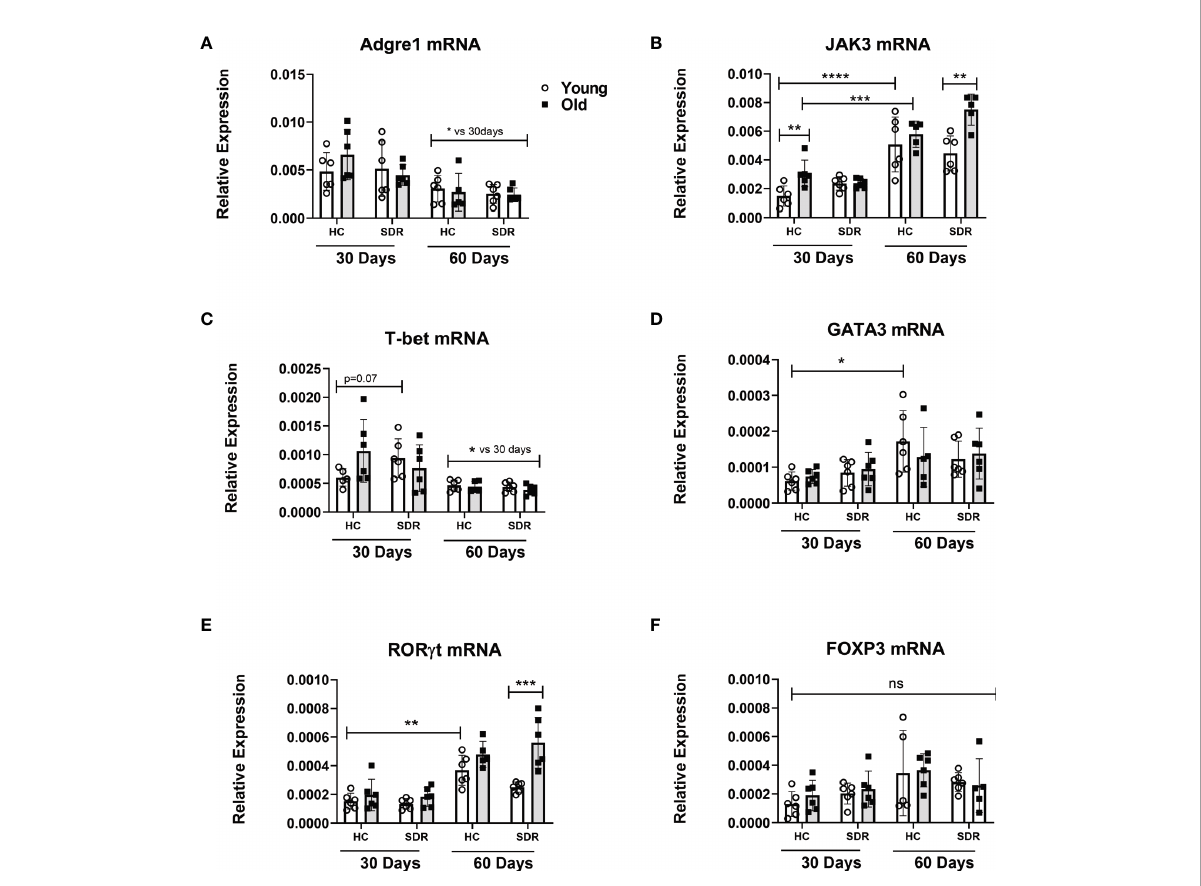
FIGURE 6 mRNA levels of macrophage and T cell genes in the lungs of mice infected with M.tb. Young and old Home Cage mice and mice subjected to six cycles of SDR were infected with low dose aerosol of M. tuberculosis for 30 and 60 days. RNA was isolated from a right lung lobe and mRNA levels (A – F) determined by qRT-PCR. RNA levels are expressed relative to b -actin. Each symbol represents individual mice. Data are shown as mean ± SE. Statistical analysis was performed by one-way ANOVA with Tukey multiple-comparisons post hoc test. Results represent 3 mice/ group per time point. Data are shown as mean ± SE. * p < 0.05, ** p < 0.01, *** p < 0.001, **** p < 0.0001. ns, non signi fi